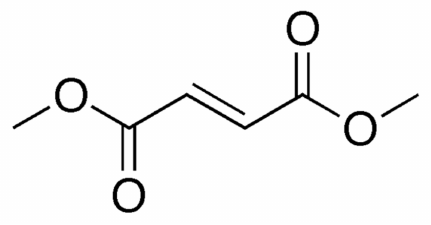
Figure 2. Organic structure of dimethyl